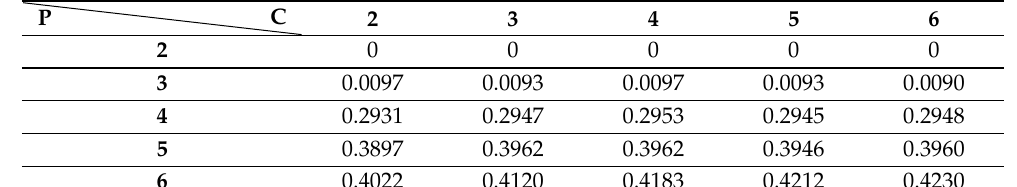
Table 2. Performance index of GM that created context flexibly.